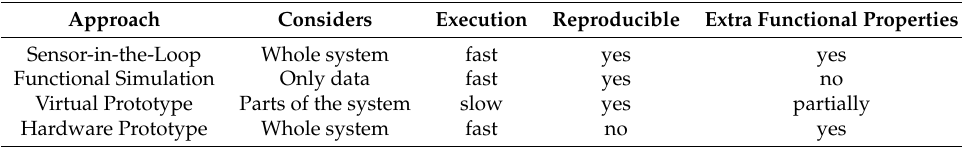
Table 1. Sensor-in-the-Loop compared to state-of-the-art